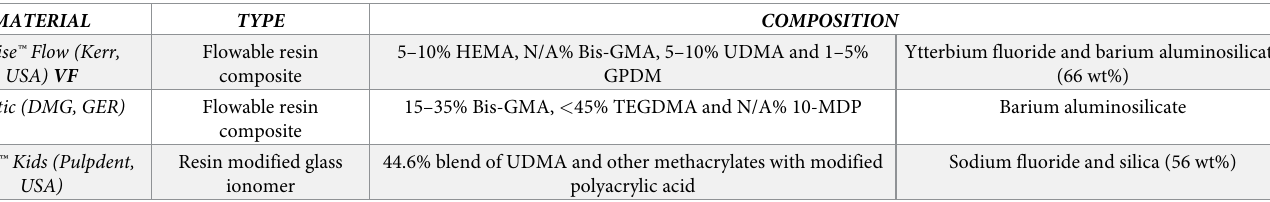
Table 1. Material composition for commercial restorative materials used in this